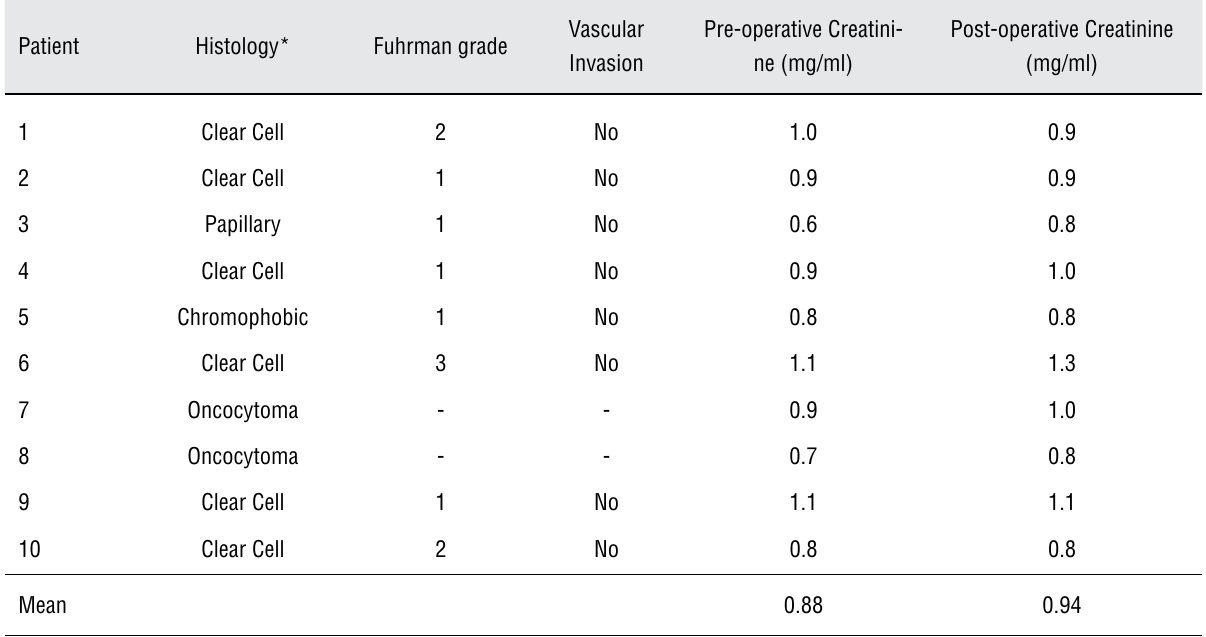
Table 2 – Pathological characteristics of kidney tumors